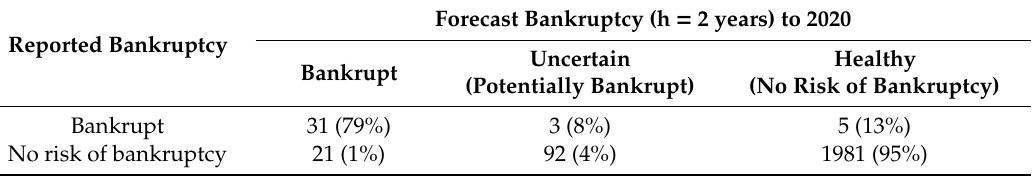
Table 5. The actual e ff ectiveness of the classification compatibility of the model verified on the basis of a sample of enterprises from the Podkarpackie